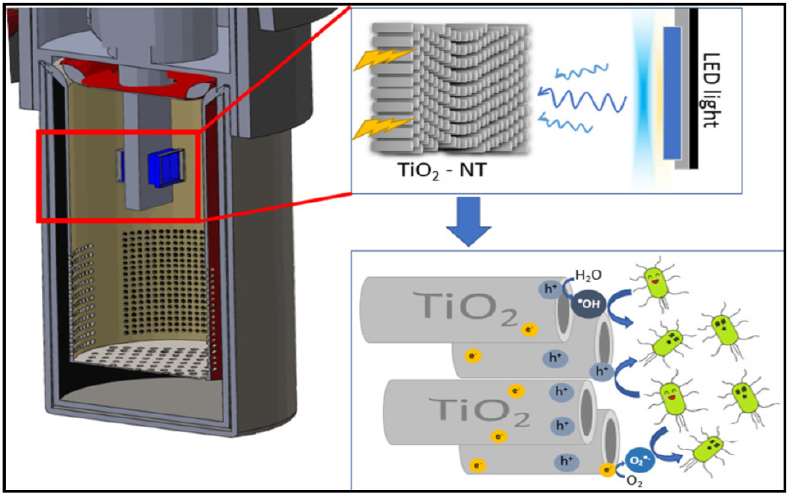
Figure 8. Photoelectric cup-like photocatalytic design for E. coli inactivation. Reprinted from [131], Copyright (2020), with permission from Elsevier.